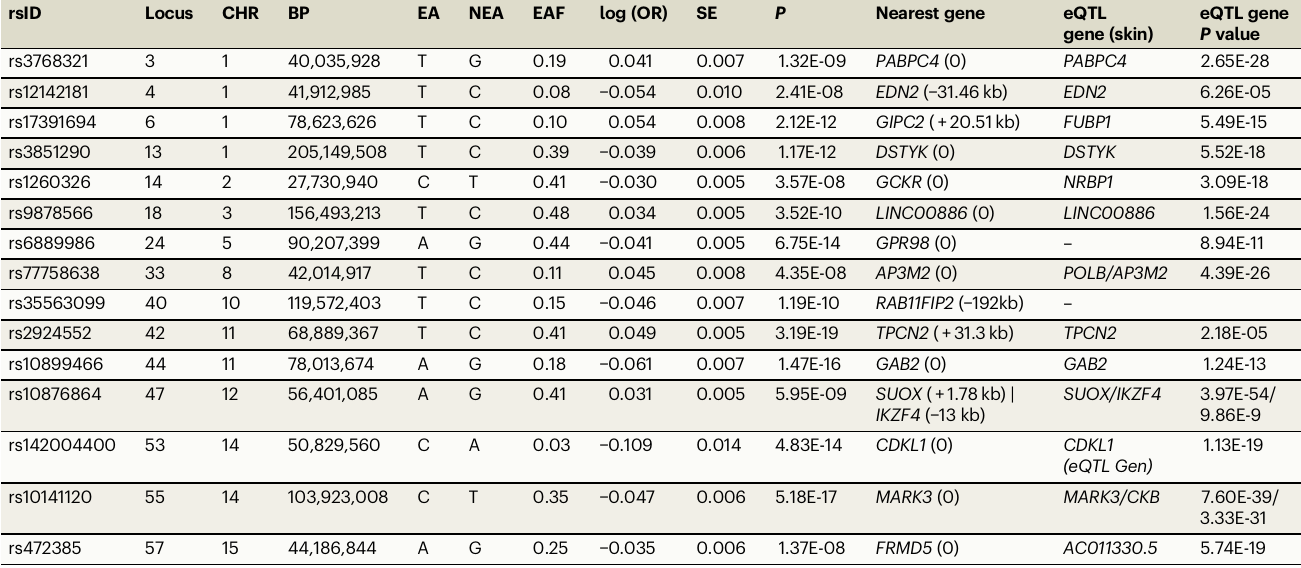
Table 2 | SCC susceptibility novel loci that replicated at P < 0.05 in 23andMe